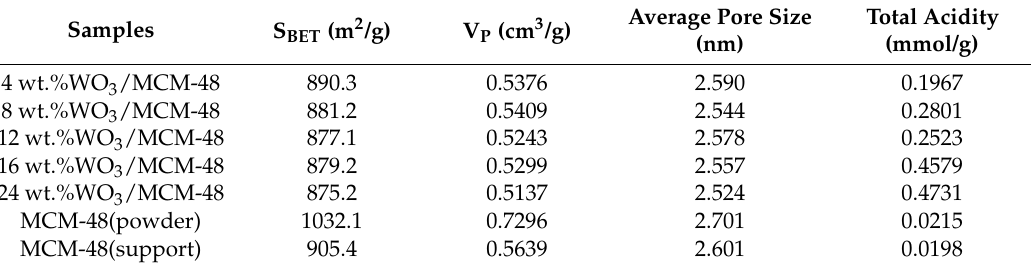
Table 1. Characteristics of WO 3